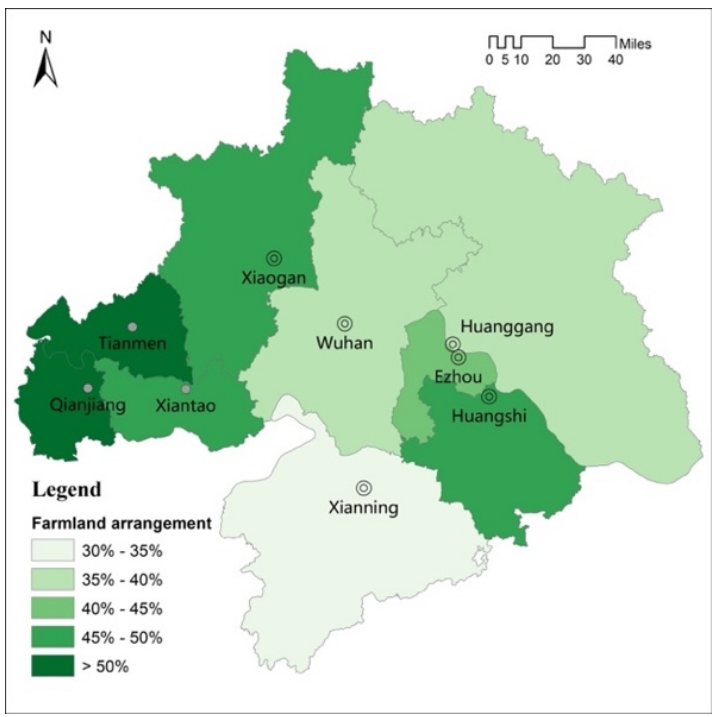
Figure 4. Spatial distribution of farmland arrangements in the Wuhan urban agglomeration.